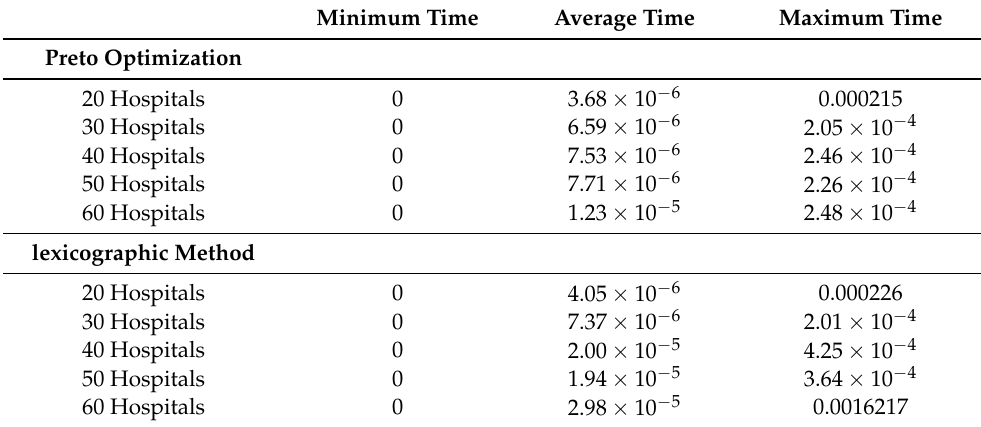
Table 5. Different times (seconds) needed to admit each patient to a hospital over a different number of